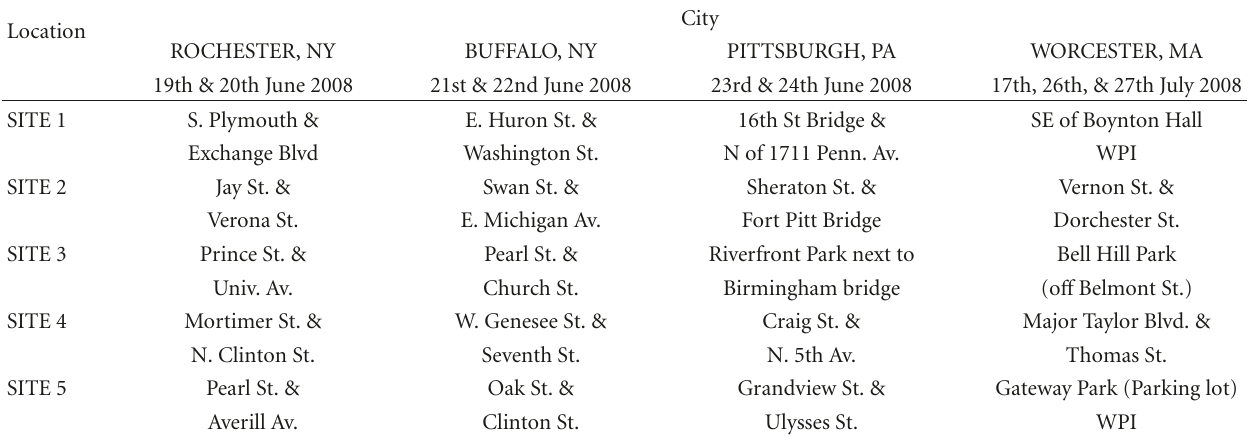
Table 1: List of spectrum measurement